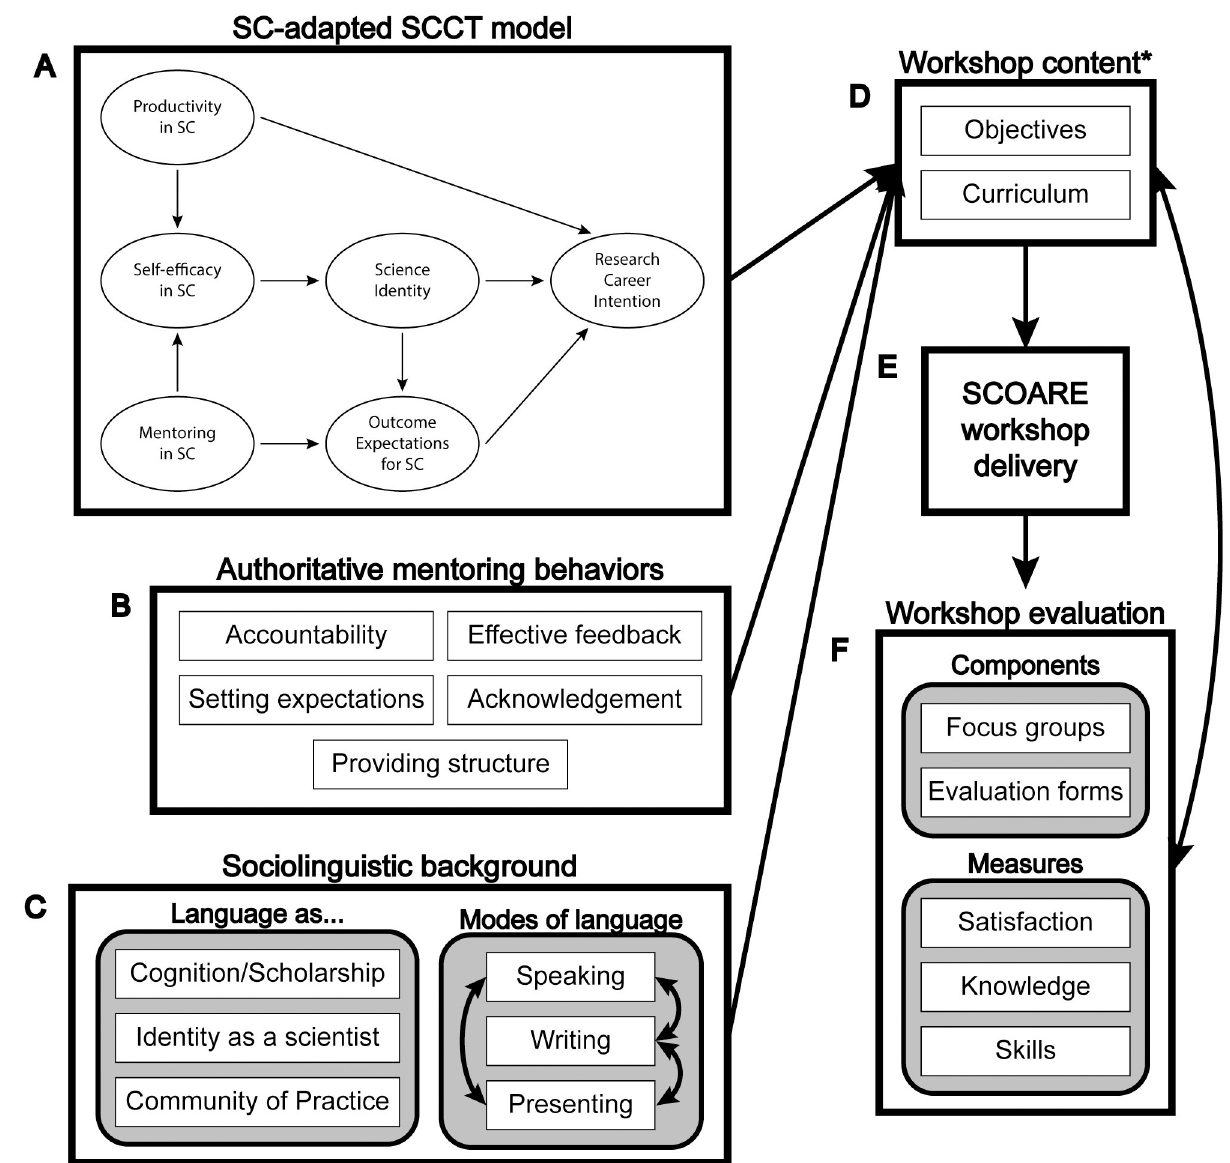
Fig 1. Flowchart of SCOARE program design and evaluation. The previously developed SC-adapted SCCT model (A), defined authoritative mentoring behaviors encompassed in the model (B), and sociolinguistic background including modes of language use and the social, psychological, and affective aspects of communication (C) were used to develop the workshop content, including objectives and curriculum (D). � Note, full workshop content, including units and the topics therein can be found in Table 1. Workshop content was delivered via the SCOARE workshop (E), then evaluated (F), and the evaluation findings were used to adapt and fine-tune the workshop